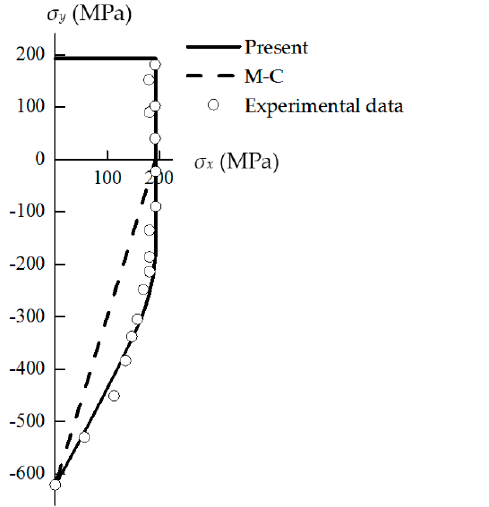
Figure 12. Failure envelopes and the experimental data of cast iron under the combined stress state σ x - σ y [29,30]. θ T = 90.0°, θ C = 37.0°. ( a ) T = 193 MPa, C = 620.6 MPa; ( b ) T = 159 MPa, C = 551 MPa.